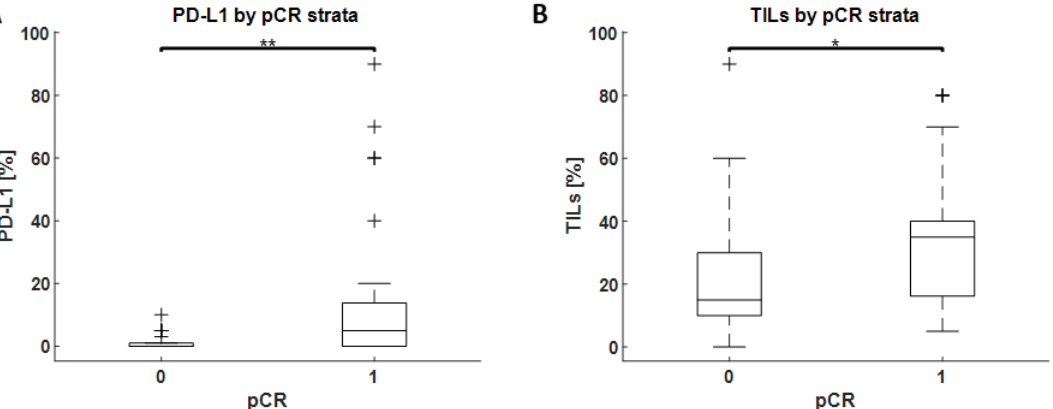
Figure 3. PD-L1 (panel A ) and TILs (panel B ) by pCR strata. ‘**’ and ‘*’ denote p -value < 0.01 and < 0.05, respectively. On each box, the middle line indicates the median value, and the bottom and top edges of the box represent the 25th and 75th percentiles, respectively. The whiskers extend to the most extreme data points that are not considered as outliers, and the outliers are plotted individually using ‘+’ sign.